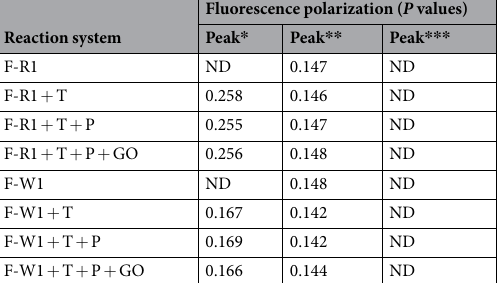
Table 2. Fluorescence polarization of each peak obtained from CE-LIFP. T: template; P: polymerase; ND: not